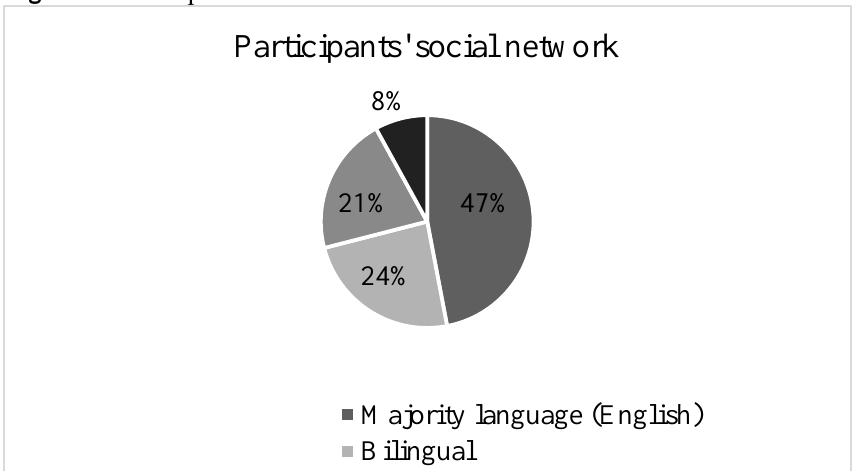
Figure 4. Participants’ social